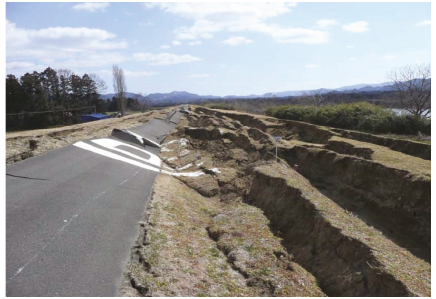
Figure 1: Damaged river embankment in the Edano area of Abukuma River [2].